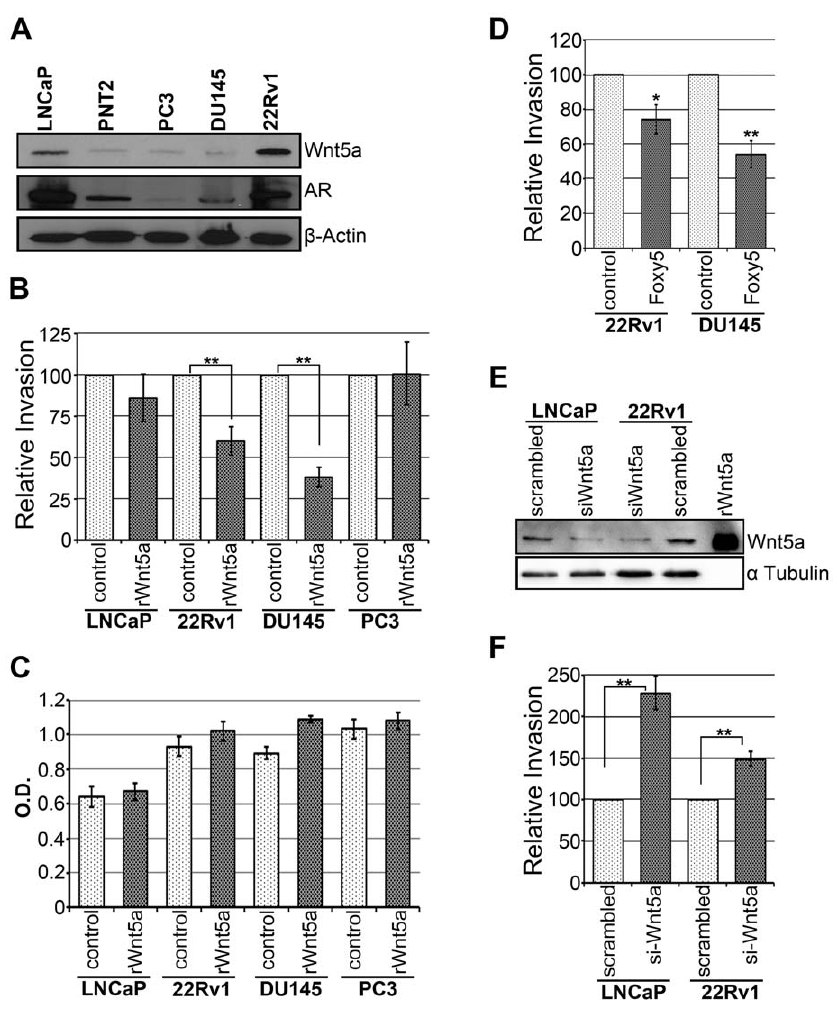
Figure 3. Analysis of Wnt5a protein expression in different prostate cell lines and its effect on PCa cell invasiveness and proliferation. A ) This panel shows the endogenous Wnt5a and AR expression in four indicated PCa cell lines (LNCaP, 22Rv1, DU145 and PC3 cells) and in one immortalized human prostate epithelial cell line (PNT2 cells). Wnt5a protein band was identified by running rWnt5a in parallel on the same gel. The blots were reprobed for b -actin as loading control. The presented blots are representative of 4 separate experiments. B ) The panel outlines the relative invasion of LNCaP, 22Rv1, DU145 and PC3 cell lines after 24 h in the absence or presence of rWnt5a (0.4 m g/ml) in the assay described in the Materials and Methods section. The results are given as means 6 SEM from 5 separate experiments. The differences in invasion between cells treated with vehicle alone or with rWnt5a were evaluated for statistical significance (p=0.0001 for 22Rv1 and p , 0.0001 for DU145). C ) The panel outlines the proliferation of LNCaP, 22Rv1, DU145 and PC3 cell lines after 24 h in the absence or presence of rWnt5a (0.4 m g/ml). The results are given as means 6 SEM from 5 separate experiments. There were no significant differences in proliferation between control and rWnt5a treated cells. D ) The panel represents the relative invasion of 22Rv1 and DU145 cells after 24 h in the absence or presence of Foxy5 (100 m M) using the same assay as in panel B. The differences in invasion between cells treated with vehicle alone or with Foxy5 were evaluated for statistical significance (p=0.01 for 22Rv1 and p=0.0003 for DU145). E ) The panel depicts the effects of siRNA knockdown of Wnt5a in LNCaP and 22Rv1. The blots were reprobed for a - tubulin as loading control. The presented blots are representative of 4 separate experiments. F ) The panel outlines the relative invasion of LNCaP and 22Rv1 cells after treatment with Wnt5a si-RNA (Wnt5a knockdown) or scrambled siRNA (control), in the same assay previously used in panel B. The results are given as means 6 SEM from 5 separate experiments. The difference in invasion between scrambled and si-Wnt5a knocked down cells were statistically significant for both cell lines (p ,